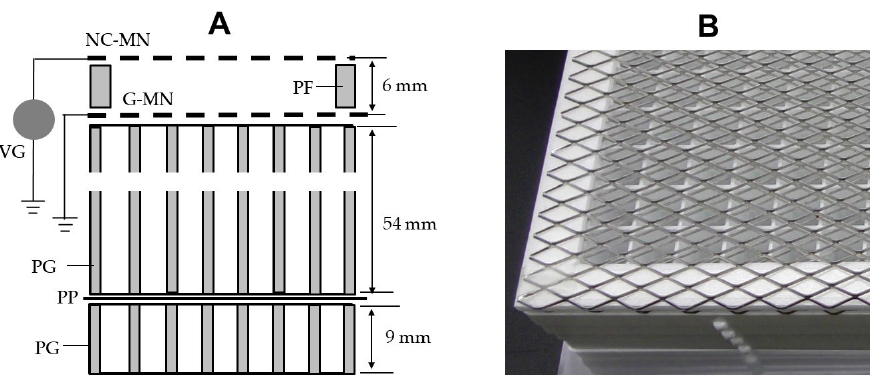
Figure 3. Schematic ( A ) and photograph ( B ) are representations of an arc ‐ discharge exposure (ADE) consisting of two metal nets, two gratings, and a pulse-type negative-voltage generator (NVG) (cross ‐ sectional view). A square polypropylene frame (PF) (6 mm in height) was placed between the negatively charged metal net (NC ‐ MN) and the grounded metal net (G ‐ MN). A plastic grating (PG) 54 mm in height was placed beneath the G ‐ MN. Another grating (9 mm in height) was placed beneath the polypropylene plate (PP), which was positioned between the two gratings and withdrawn before the experiment. Pupae or CO 2 ‐ anesthetized adult houseflies were placed in separate cells of the lower grating.